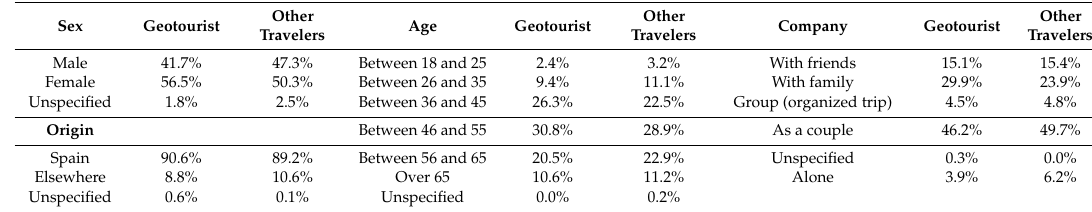
Table 7. Main characteristics of visitors to the geopark by